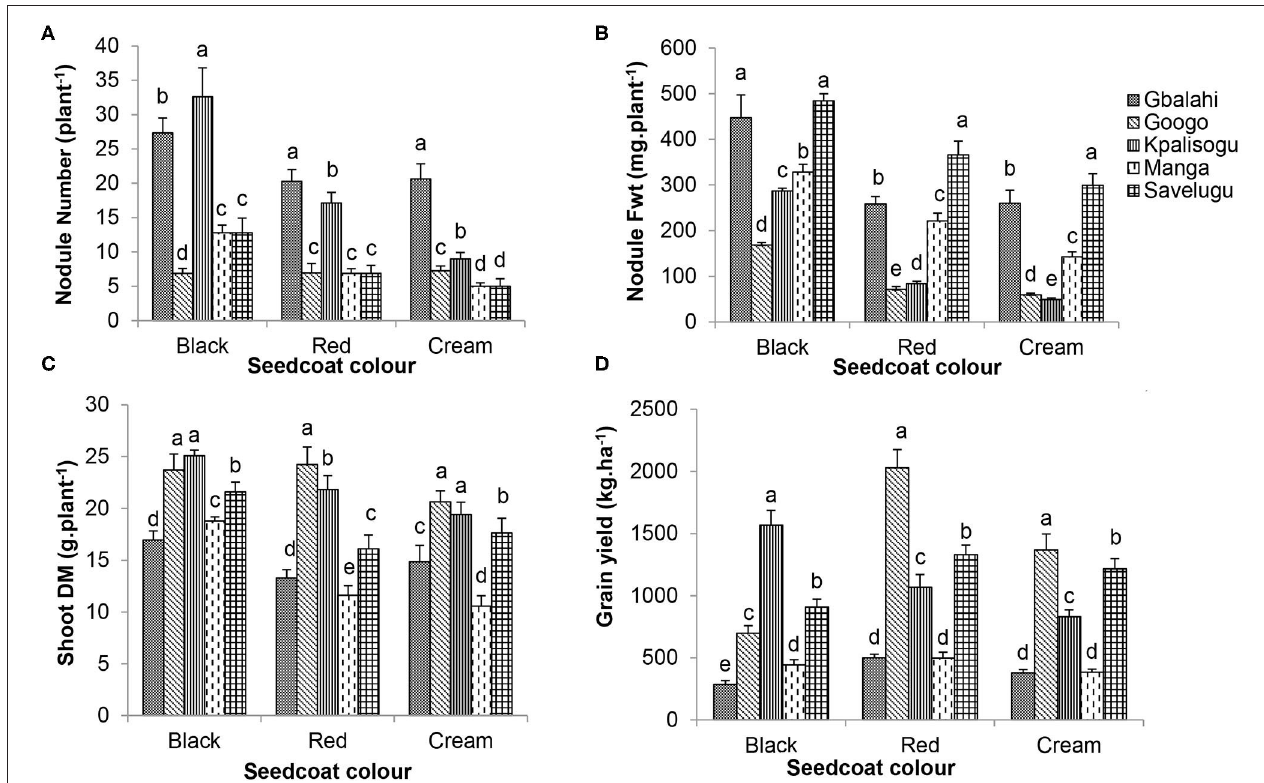
FIGURE 1 | Interactive effects of seedcoat colour × environment on (A) nodule number per plant, (B) nodule Fwt, (C) shoot DM of Bambara groundnut plants sampled at flowering (56 DAP), and (D) grain yield at harvest. Bars with dissimilar letters are significantly different.